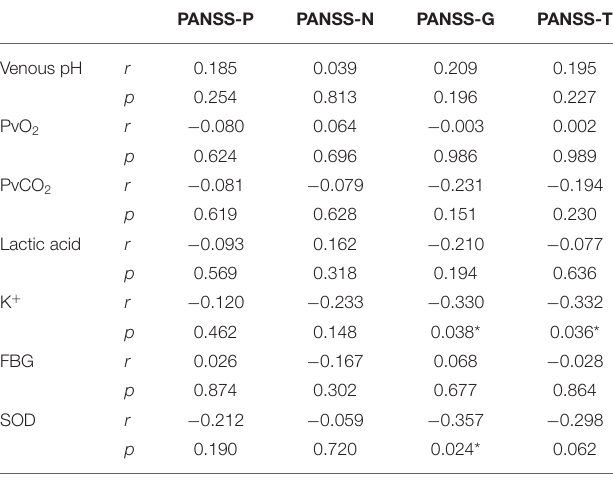
TABLE 5 | Correlation analysis of PANSS scores and other effect indicators. PANSS-P PANSS-N PANSS-G PANSS-T Venous pH